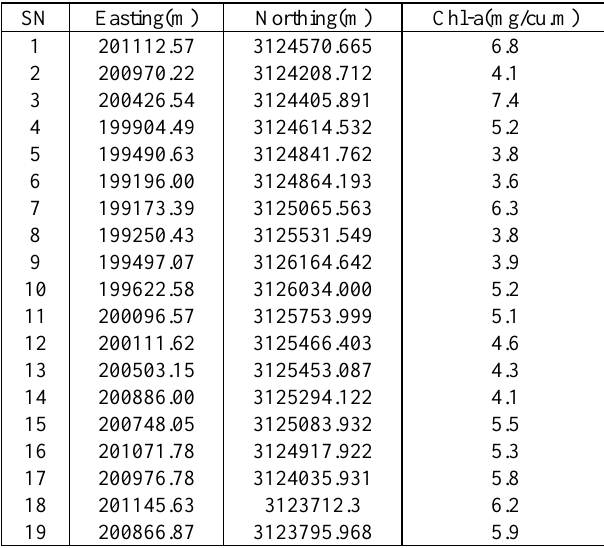
Table 1. Geolocation of sampled point with Chl-a